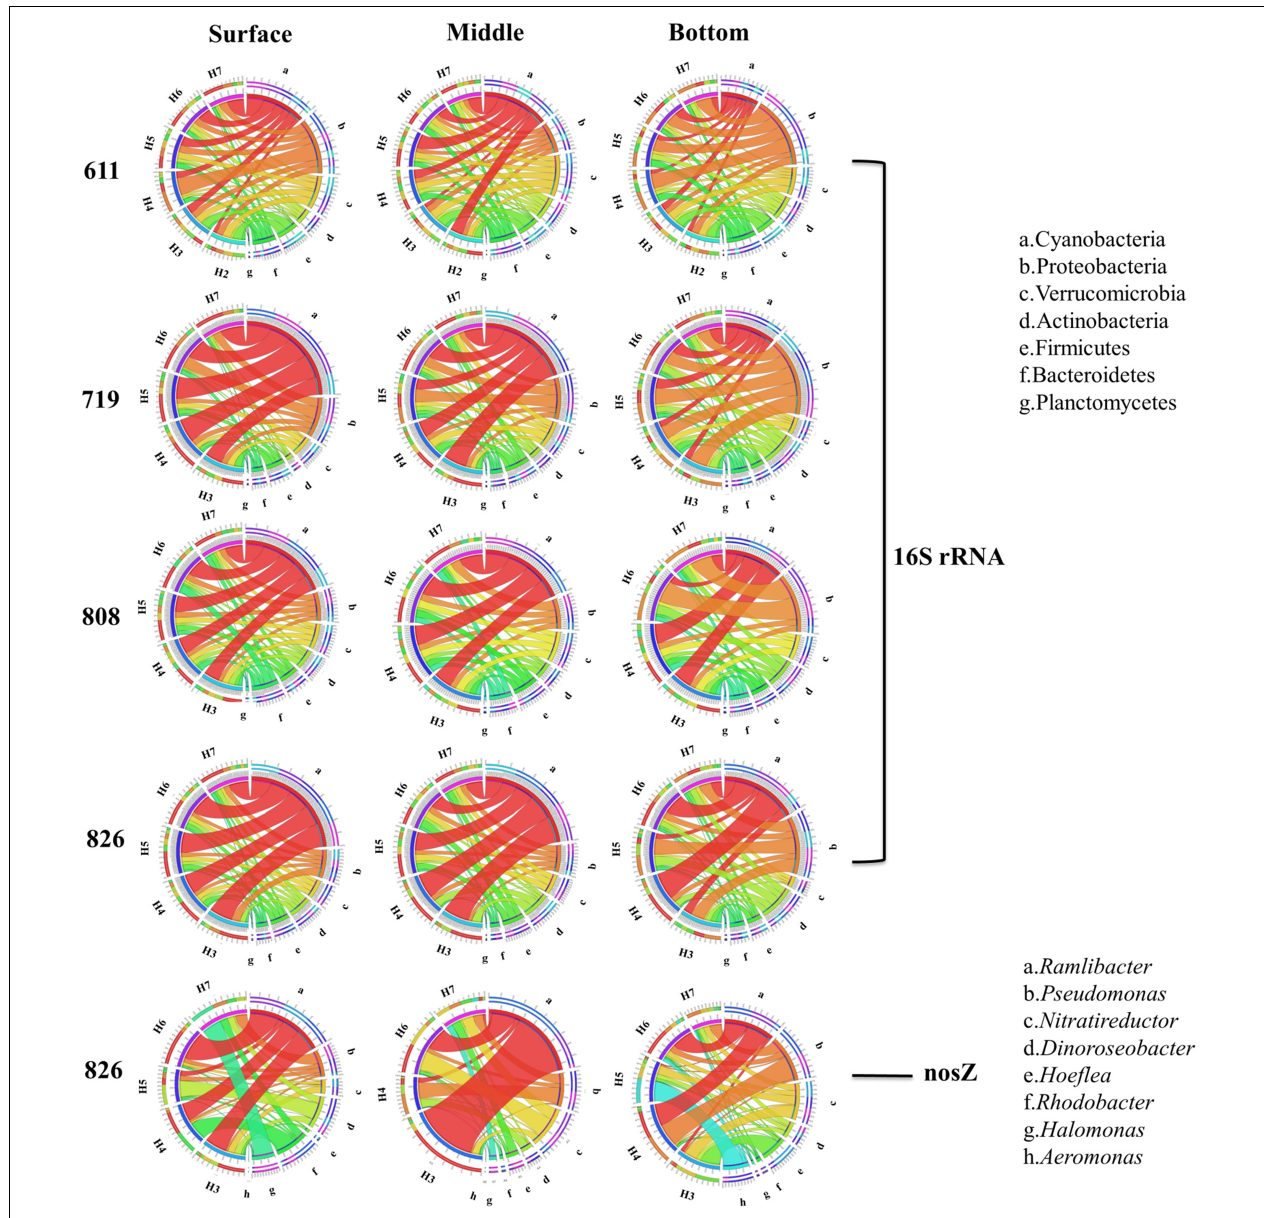
FIGURE 4 | The community composition of 16S rRNA (phylum level) and nosZ gene denitrifiers (genus level) was revealed by